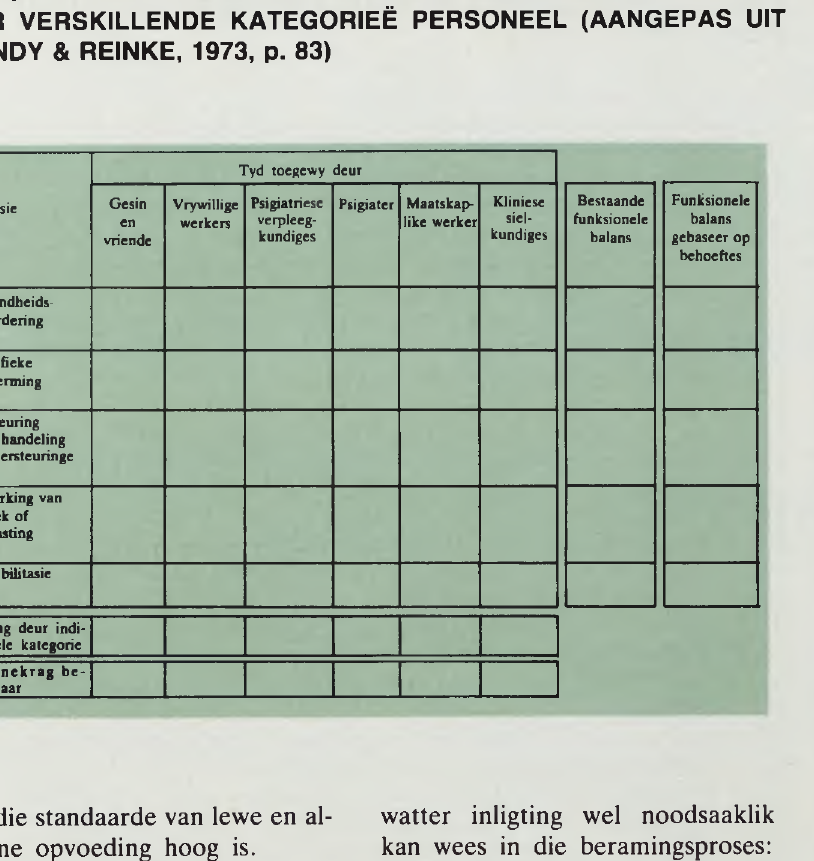
Tabel 3: ’N ANALISE VAN TYD TOEGEWYS AAN VERSKEIE FUNKSIES DEUR VERSKILLENDE KATEGORIEË PERSONEEL (AANGEPAS UIT GRUNDY & REINKE, 1973, p.